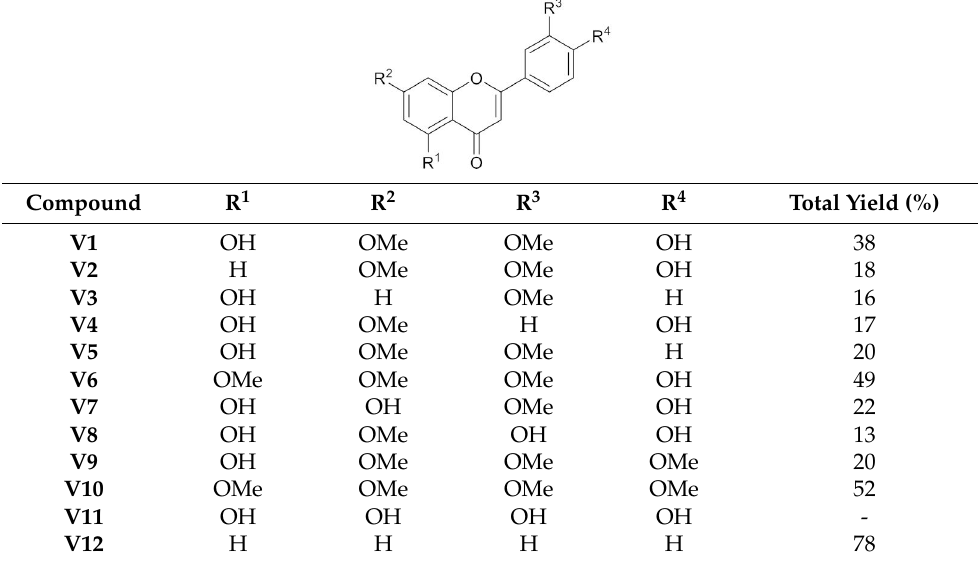
Table 1 summarizes the substitution group and the overall yield of the synthesized velutin derivatives. Table 1. Substitution group and overall yield of the synthesized velutin